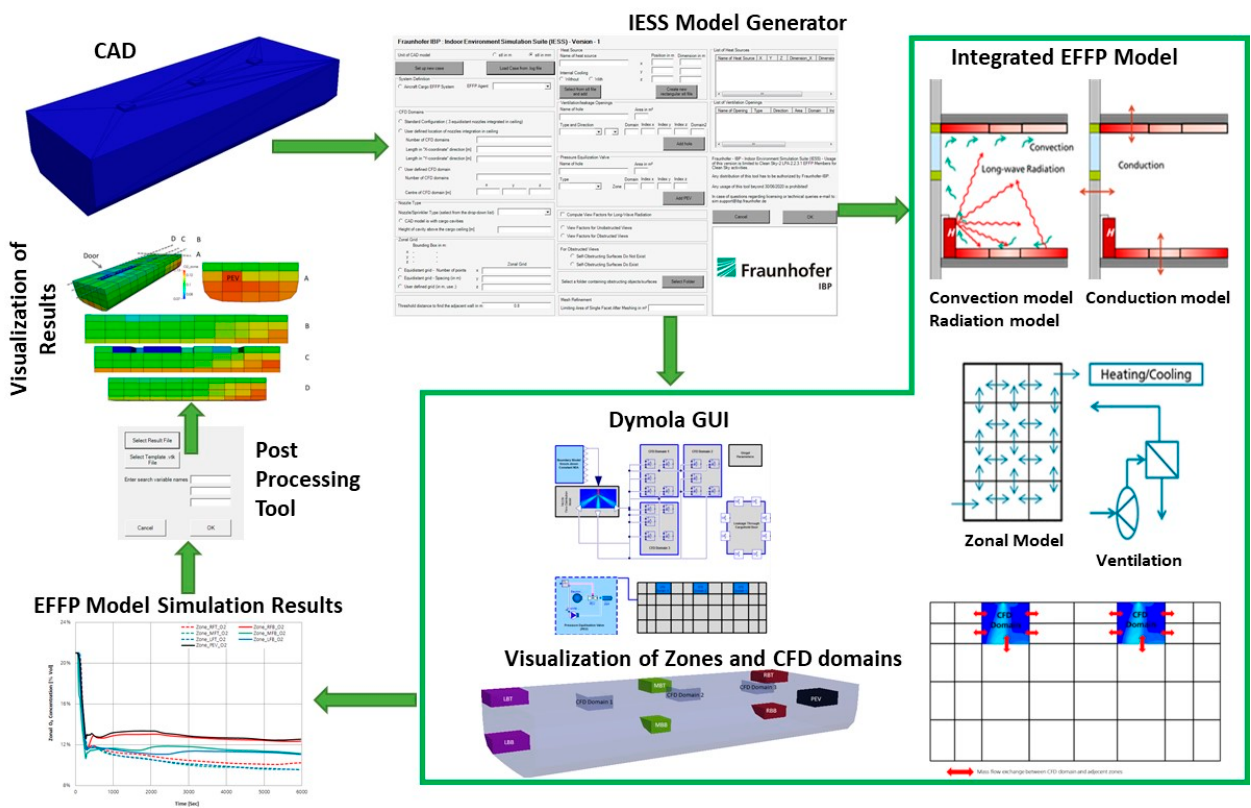
Figure 1. Indoor Environment Simulation Suite (IESS) workflow.